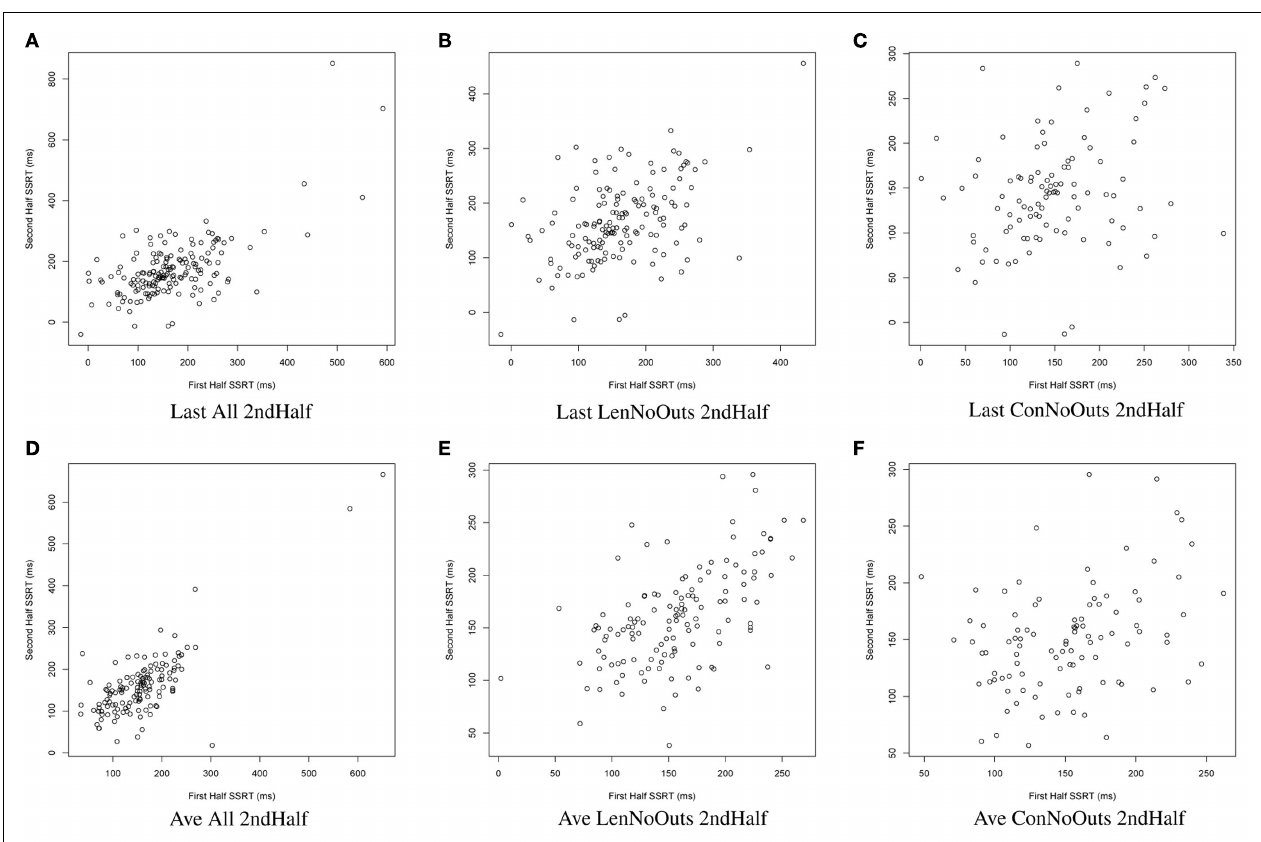
includes an average of all available runs.The first column includes all available subjects; the second column excludes those subjects exceeding Lenient Outlier criteria; and the third column excludes those subjects exceeding Conservative Outlier criteria. Each of these six approaches used only the second half of trials from the selected runs. SSRT, stop-signal reaction